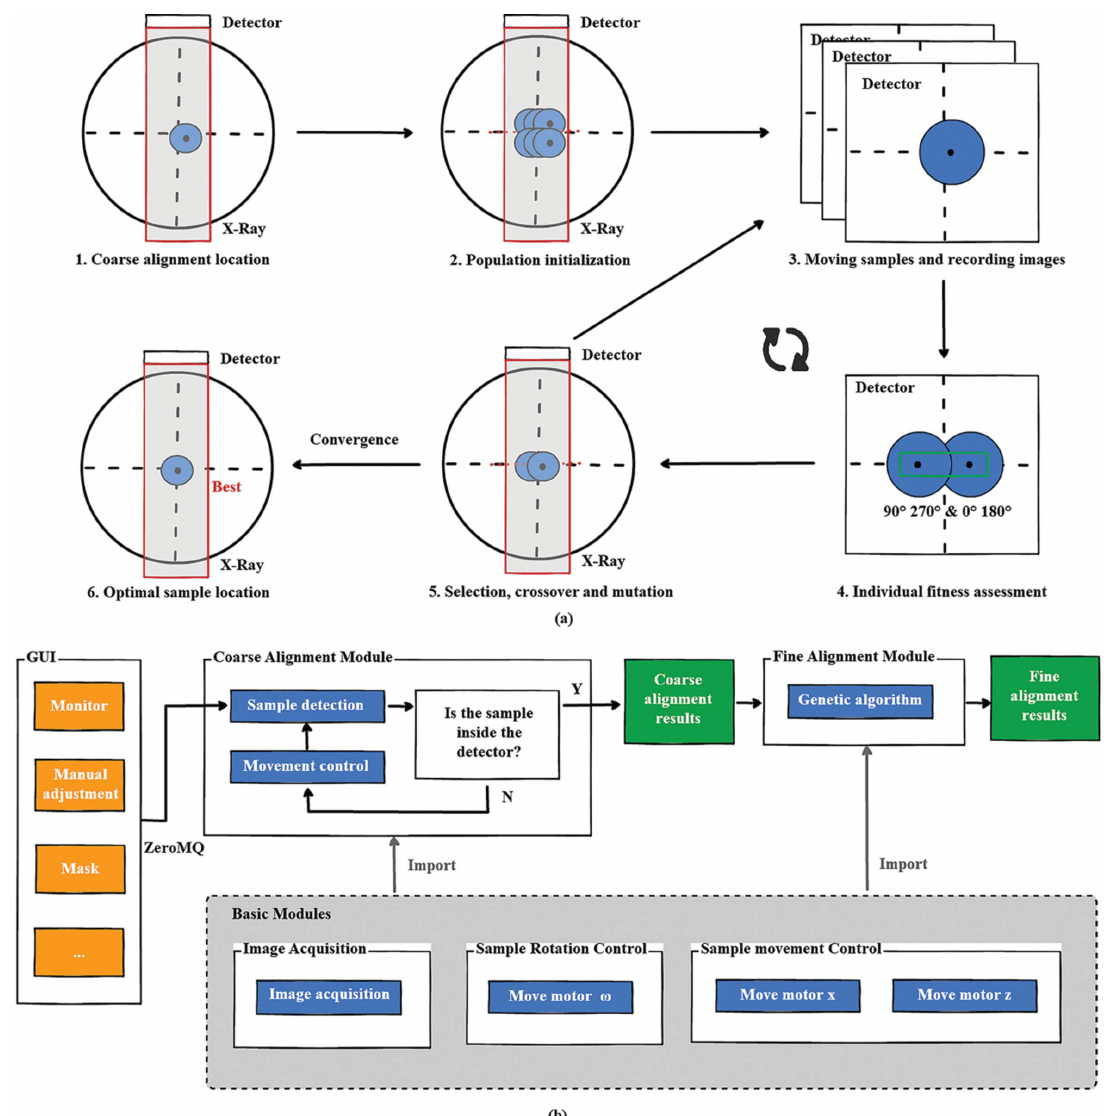
Figure 5 ( a ) The process of fine sample alignment. ( b ) Framework design of the sample alignment software. The blue color indicates the sample alignment algorithm and its associated functional modules, and the orange color indicates the GUI